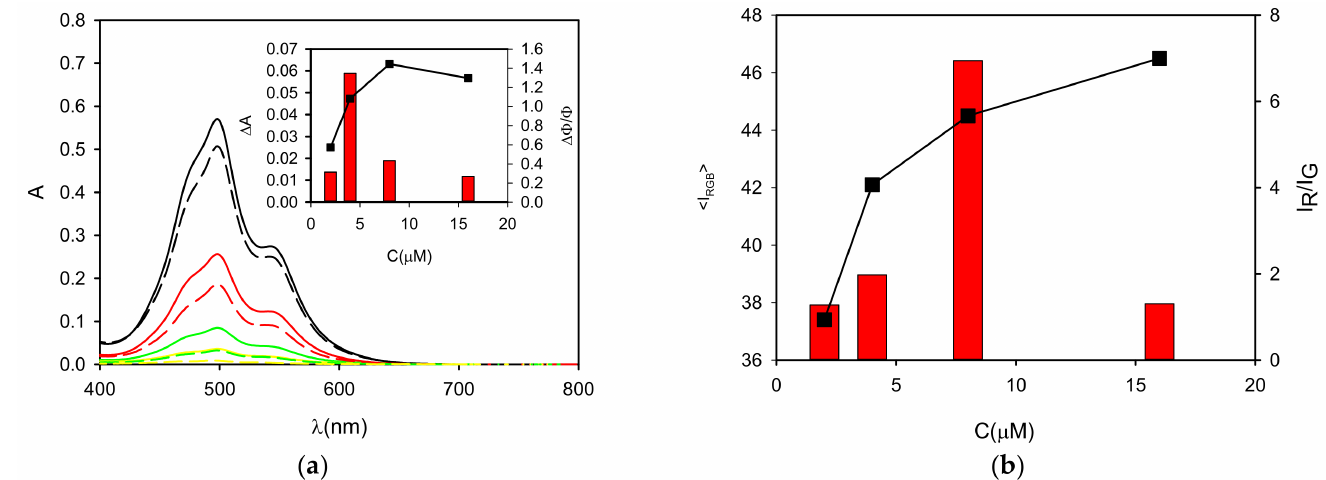
Figure 4. ( a ) Absorption spectra of P in buffered neutral water (pH = 7) at concentrations 16, 8, 4 and 2 µ M (black, red, green and yellow lines, respectively) before (continuous line) and after (dashed lines) 2 h incubation with PVC (5 mg in 2 mL solution). The decrease of the absorbance of the solution is plotted in the inset (black squares) as a function of the concentration. The relative increase of the fluorescence intensity of the solution at 540 nm after incubation is plotted as red bars. ( b ) The total intensity measured by wide field microscopy for the PVC particles after the incubation is shown as a function of P concentration (<I RGB >). The ratio of the intensity on the red and green channels (I R /I G ) is plotted as red